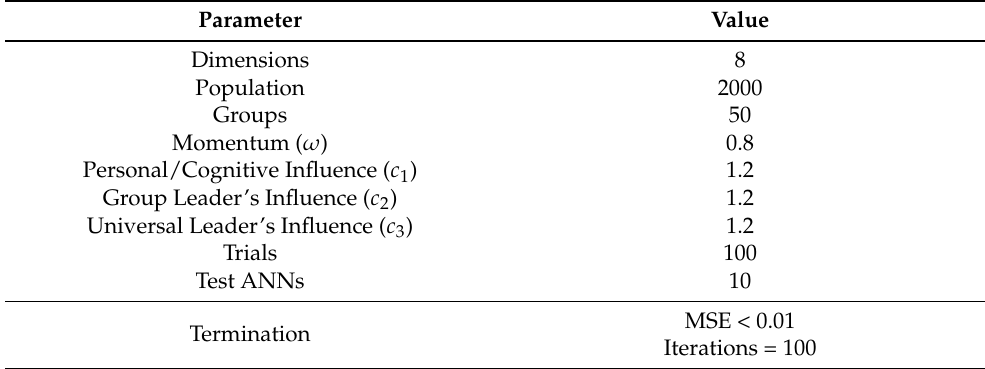
Table 2. Parameters used in optimization.